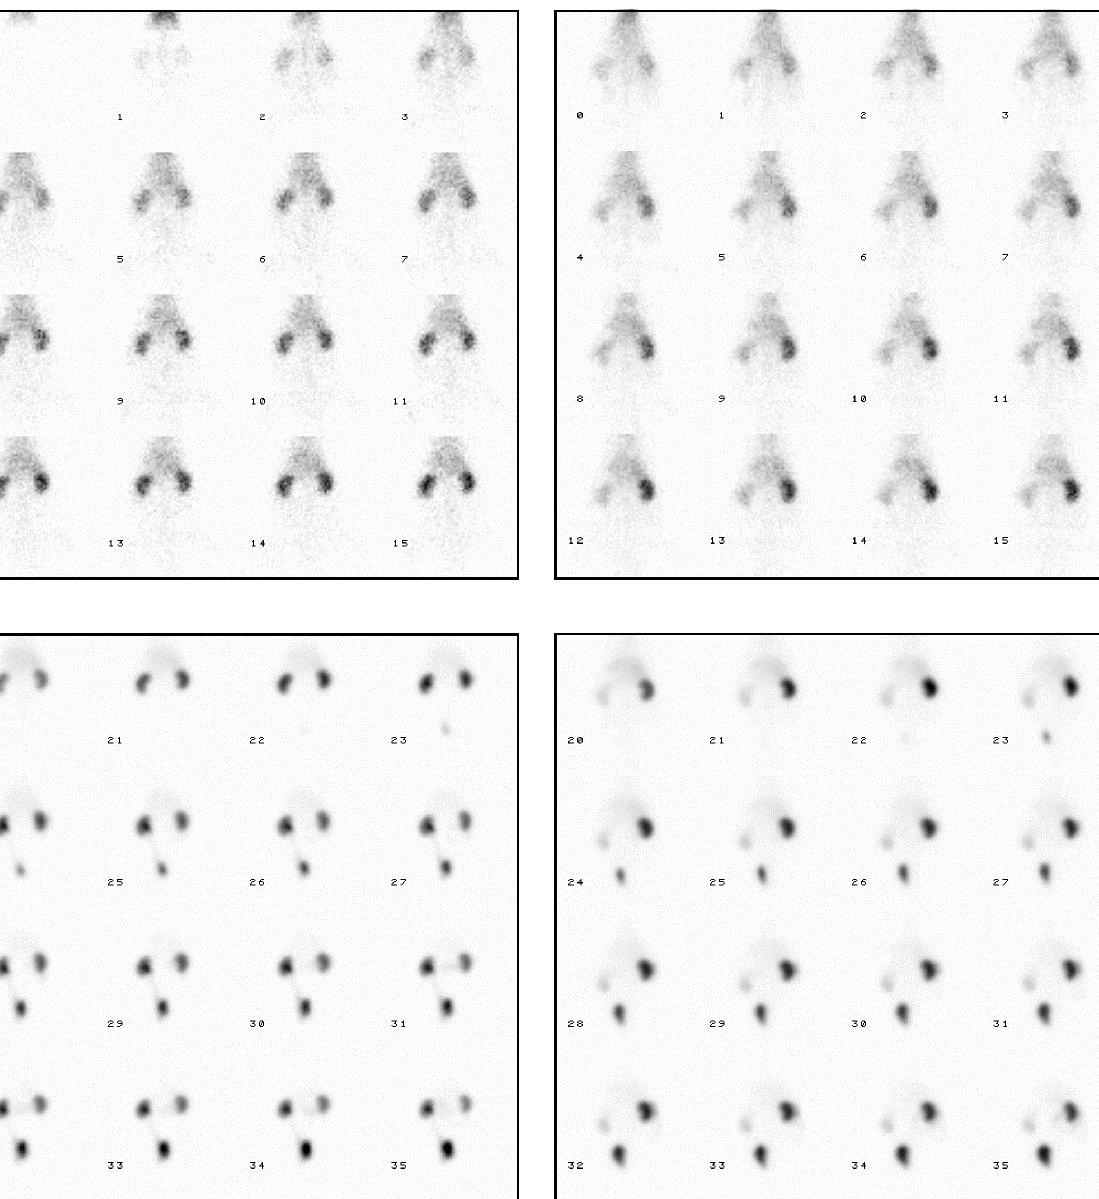
Figure 02 - Ischemia without chlorpromazine (group B). Basal study (A1 and A2) with normal perfusion and functional pattern bilaterally, and 24 hours study (B1 and B2) showing marked and statistically significant decreased left renal function, post ischemic insult (p<0,001;